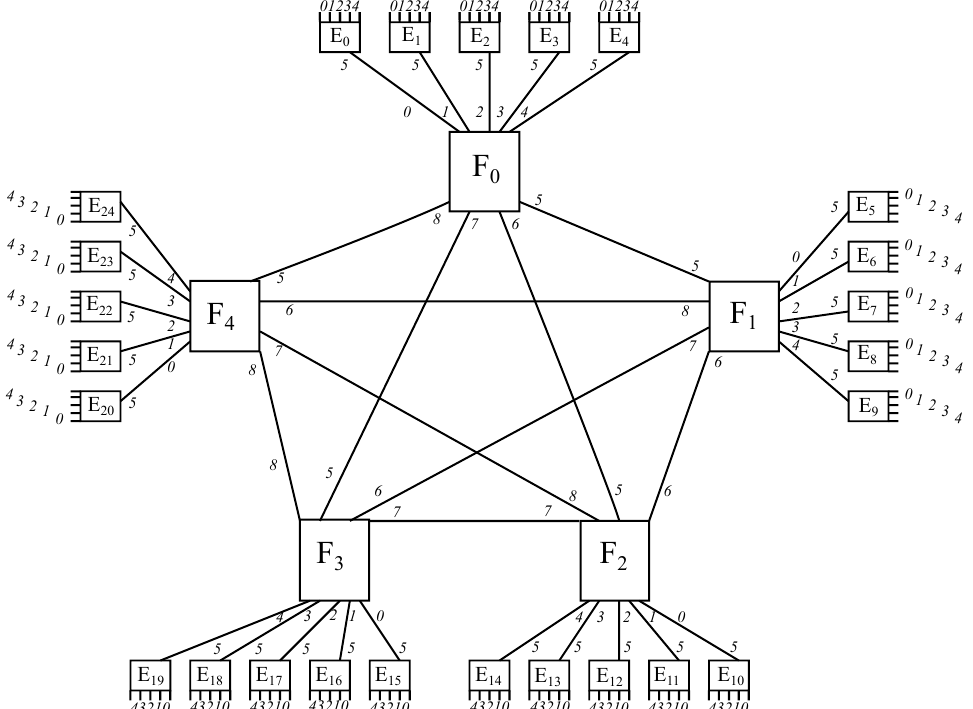
Figure 13. Port layout for full mesh fog communication when k =